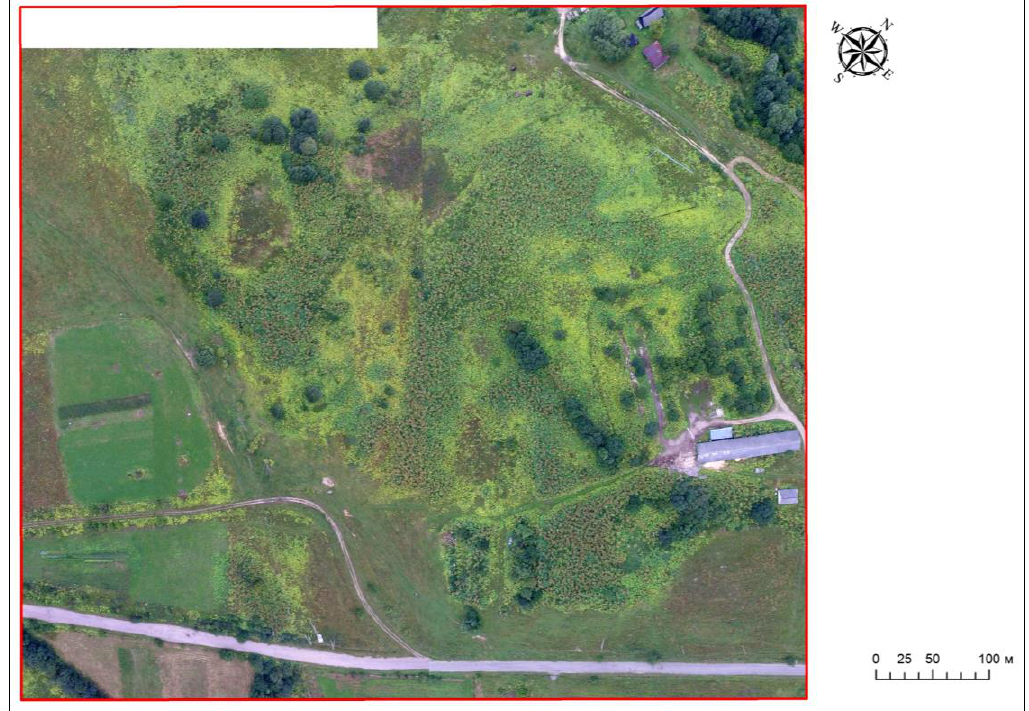
Fig. 3. Comprehensive picture of the territory occupied by Heracleum sosnovskyi in Turka district of the Lviv region (July 2016) (Shtoiko,